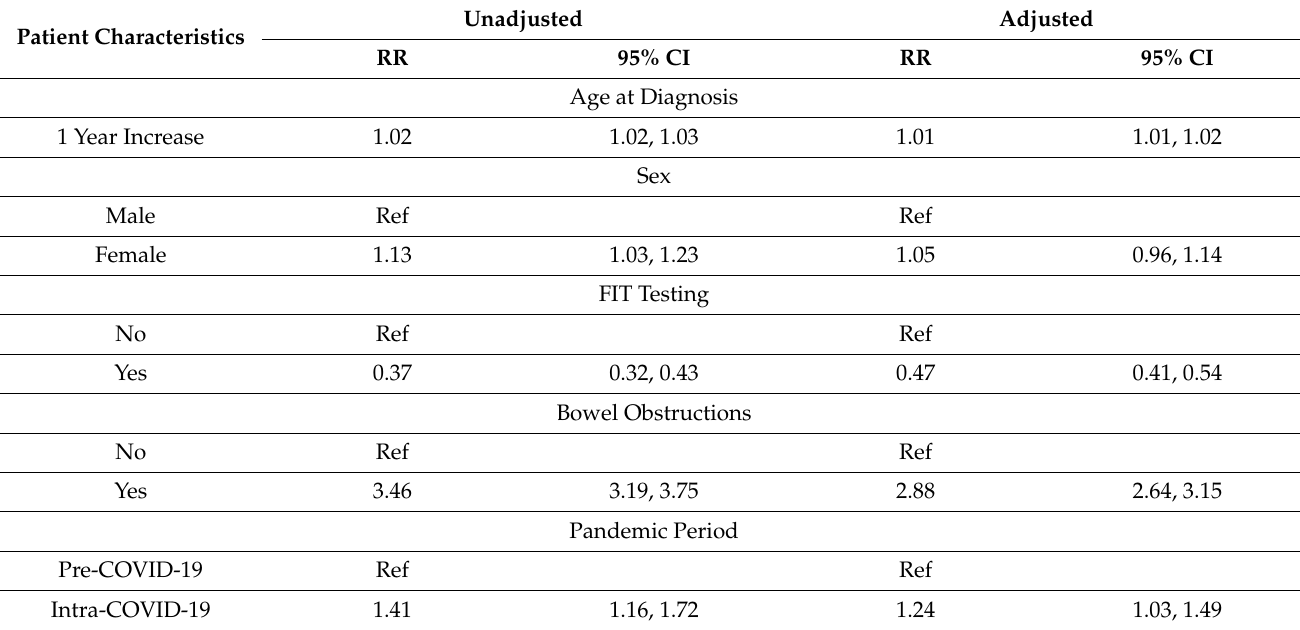
Table 4. Unadjusted and adjusted relative risks (RR) and 95% confidence intervals (CI) for the effects of patient characteristics and diagnosis period for being diagnosed while admitted to